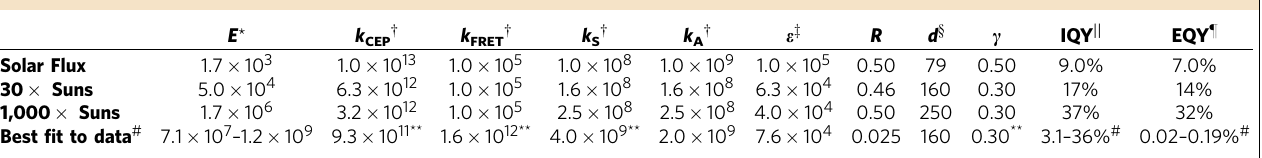
Table 1 | Select CEP parameters and upconversion yields.